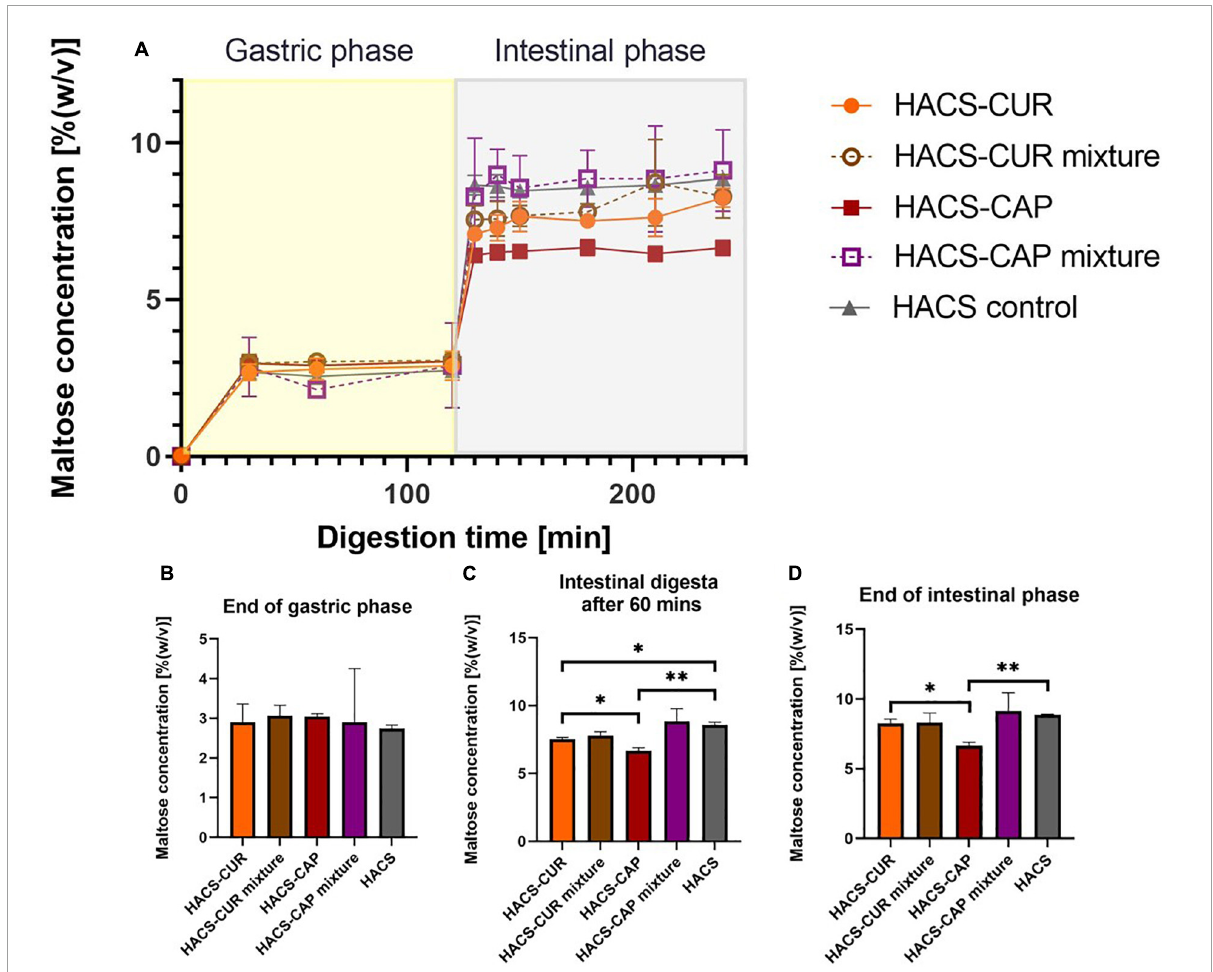
FIGURE6 (A) Starch hydrolysis as maltose concentration in an adult in vitro digestion model. Bar charts can be seen at specific time points: (B) at the end of gastric phase, (C) after 60 min in the intestinal phase, and (D) at the end of intestinal phase. * p < 0.05, ** p <